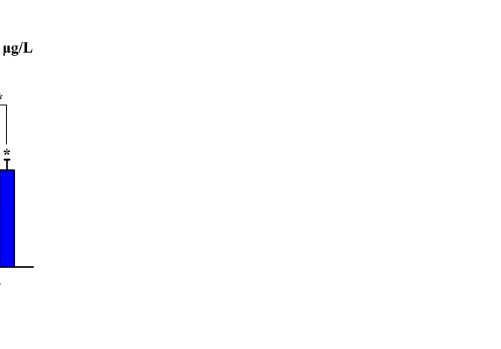
Figure 5. Regulation of seven hyper-methylated genes (BMP 7 α , BMP 8, WNT 6, protein kinase C δ , Rac 1, actinin α 2 and myosin) expression by S- fipronil or R- fipronil at the concentration of 800 μ